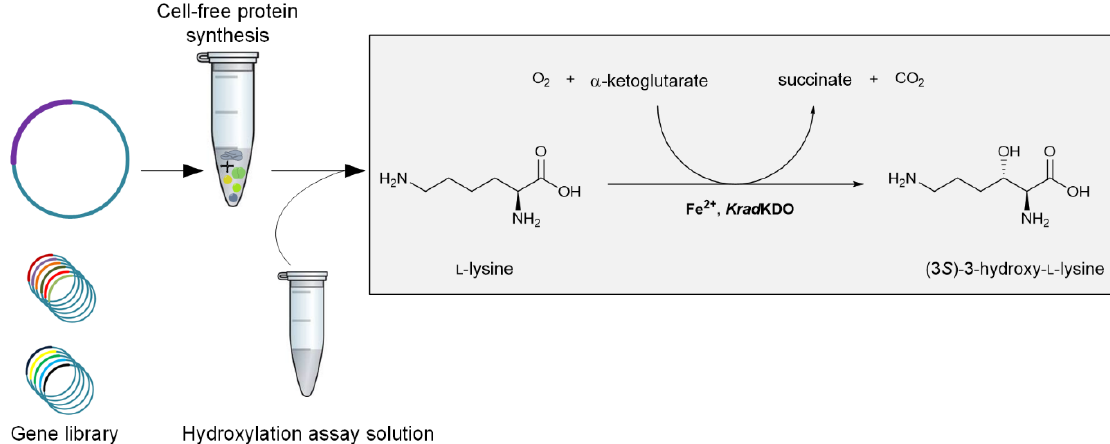
Figure 1. Schematic procedure for screening novel lysine dioxygenases (KDOs) with cell-free protein synthesis (CFPS). Exemplary reaction for the KDO from Kineococcus radiotolerans ( Krad KDO).